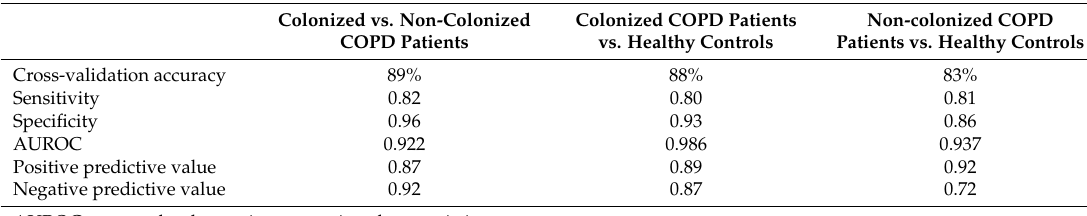
Table 2. Receiver operating characteristics analyses of breath-prints between colonized COPD patients, non-colonized COPD patients and healthy controls. Used with permission from